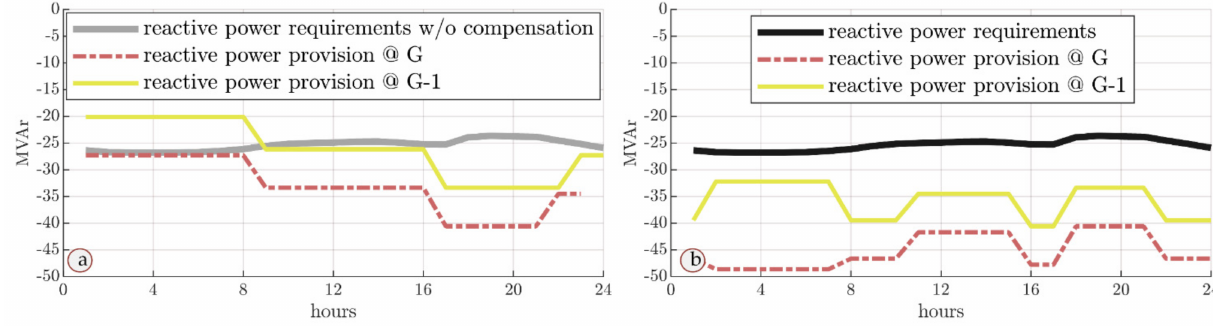
Figure 5. Fulfillment of system reactive power requirements by online thermal units at G and G-1 conditions, for the operating conditions of Figure